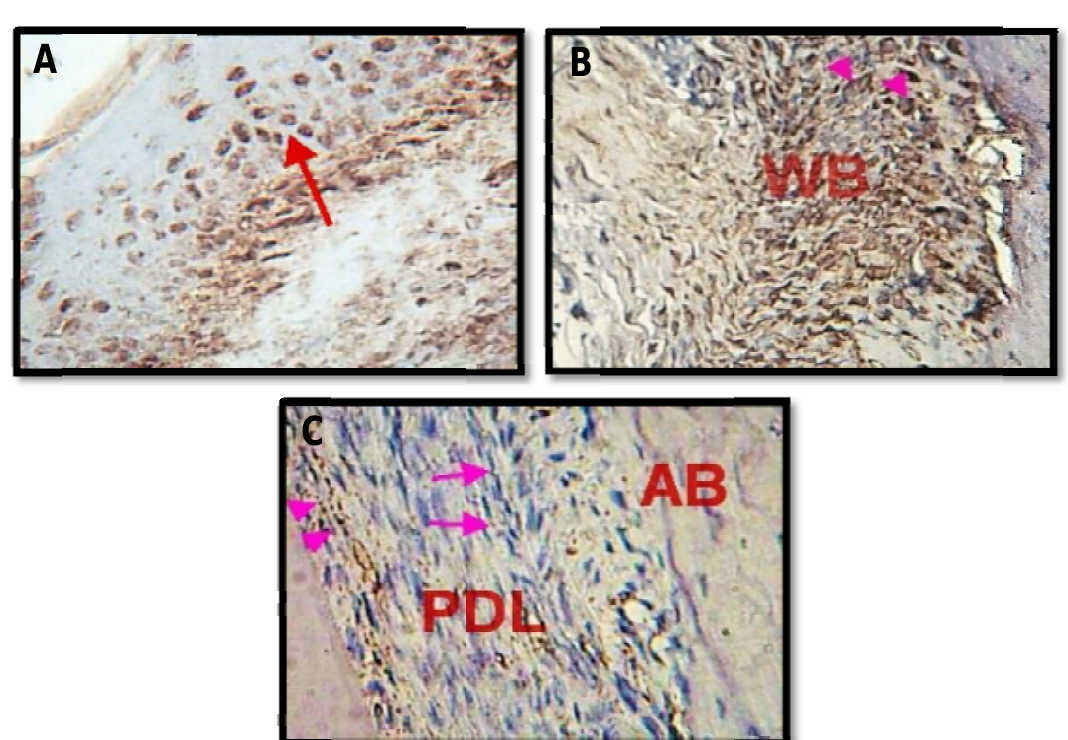
Figure 1: Control group with immunohistochemical expression of syndecan 1 (DAB Stain) ( At 3 rd day, Keratinocyte cell (arrow)expressed positive DAB stain for syndecan -1.DAB stain X20. (B) At 7 th day, Woven bone (WB) shows positive expression of syndecan -1by osteoblast (arrow heads) .DAB stain X20. (C) At 14 th day,View for periodontal ligament (PDL) , alveolar bone (AB) shows positive immune reaction for syndecan -1 by cementoblast (arrow heads) fibroblast shows negative (arrows) .DAB stain X20.